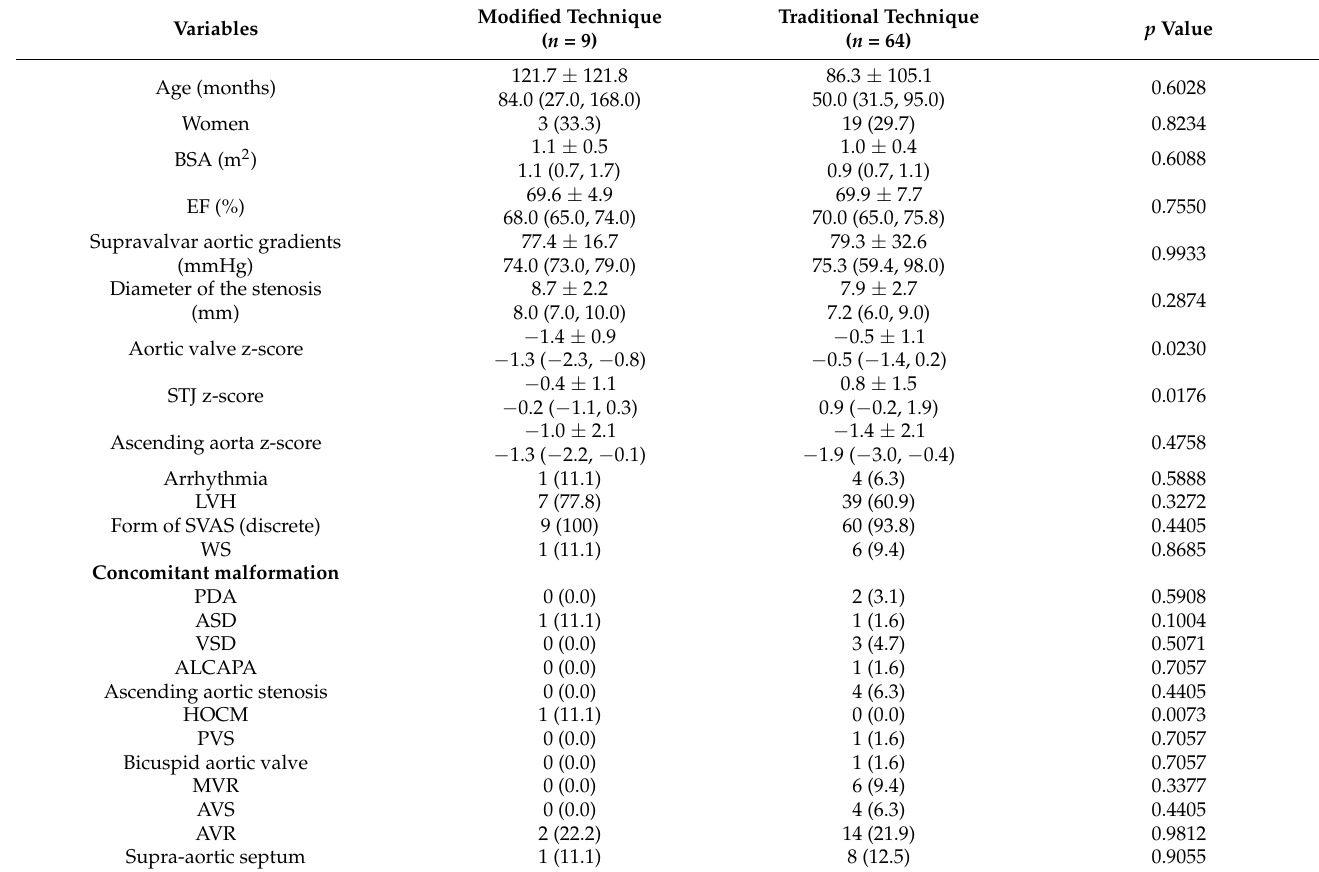
Table 1. Baseline characteristics of the patients with the modified and traditional technique.